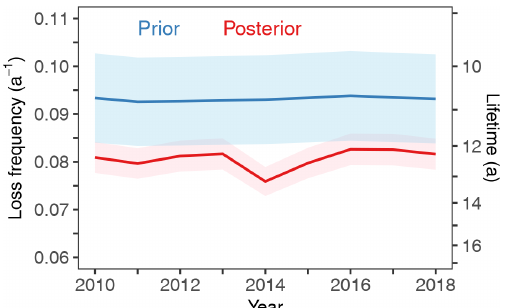
Figure 13. Methane loss frequency and lifetime against oxidation by tropospheric OH for 2010–2018. Values are annual means with error standard deviations. The loss frequency ( k ) is as calculated by Eq. (1) and the lifetime ( τ ) is the inverse. The prior estimate from Wecht et al. (2014) assumes no 2010–2018 trend in OH concentra- tions; the slight variability seen in the figure is due to